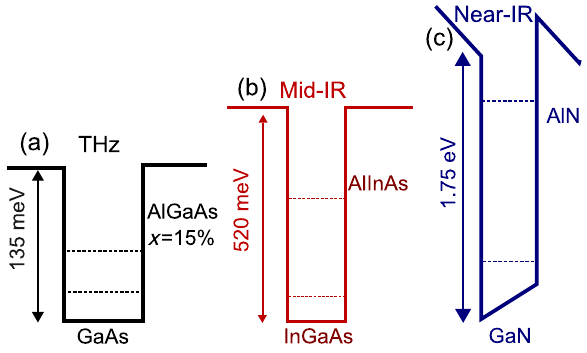
FIG. 1. Conduction-band energy profile of semiconductor QWs for the three different spectral regions studied in this work. (a) GaAs = Al 0 GaAs 0 with a band offset of 135 meV for the . 15 . 85 THz range, (b) InGaAs = AlInAs with a band offset of 520 meV for the mid-IR range, and (c) Gan = AlN with a band offset of 1.75 eV in the near-IR